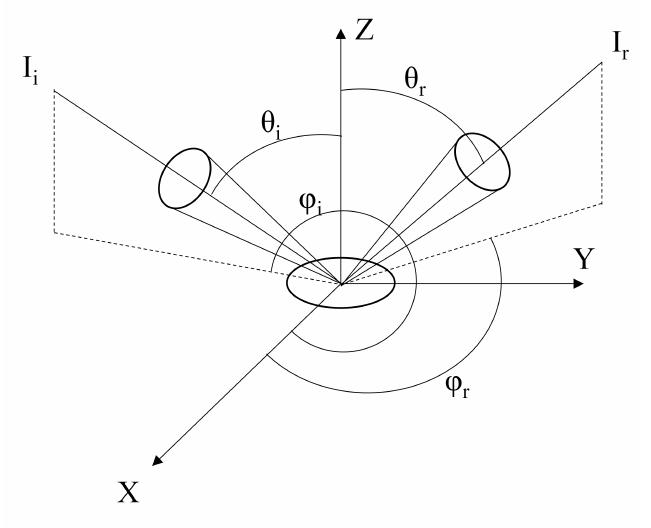
Figure 1. Diagram of the light angles in BRDF